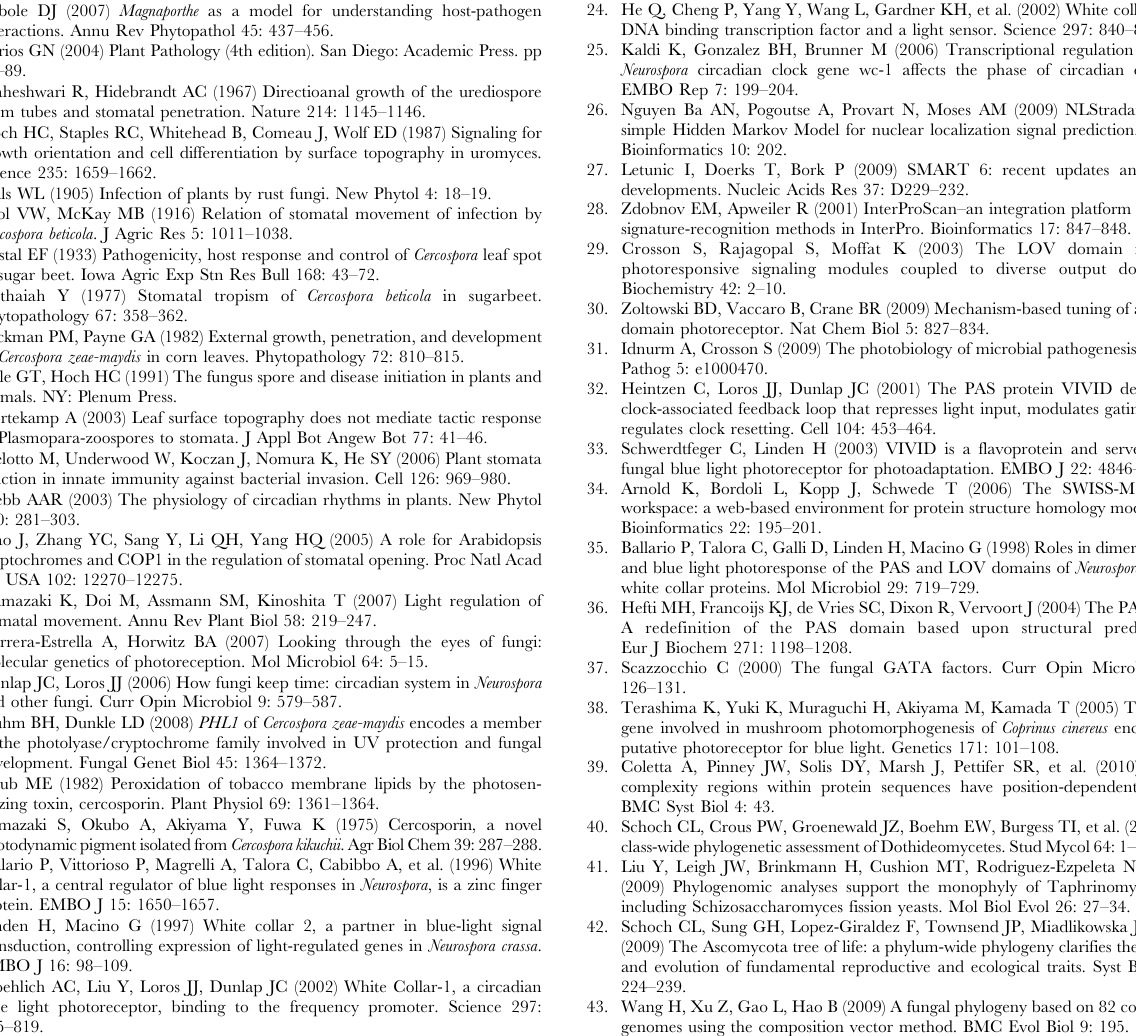
Figure S3 Photoreactivation of CRP1 (control). Ten-fold serial dilutions of conidia (10 3 , 10 2 , and 10) from each strain were inoculated on V8-agar medium, and exposed to UV light (3 mW/ cm 2 , 90 min). After UV irradiation, cultures were placed in constant darkness for three days. Table S1 Effects of blue light on conidiation and cercosporin biosynthesis of Cercospora